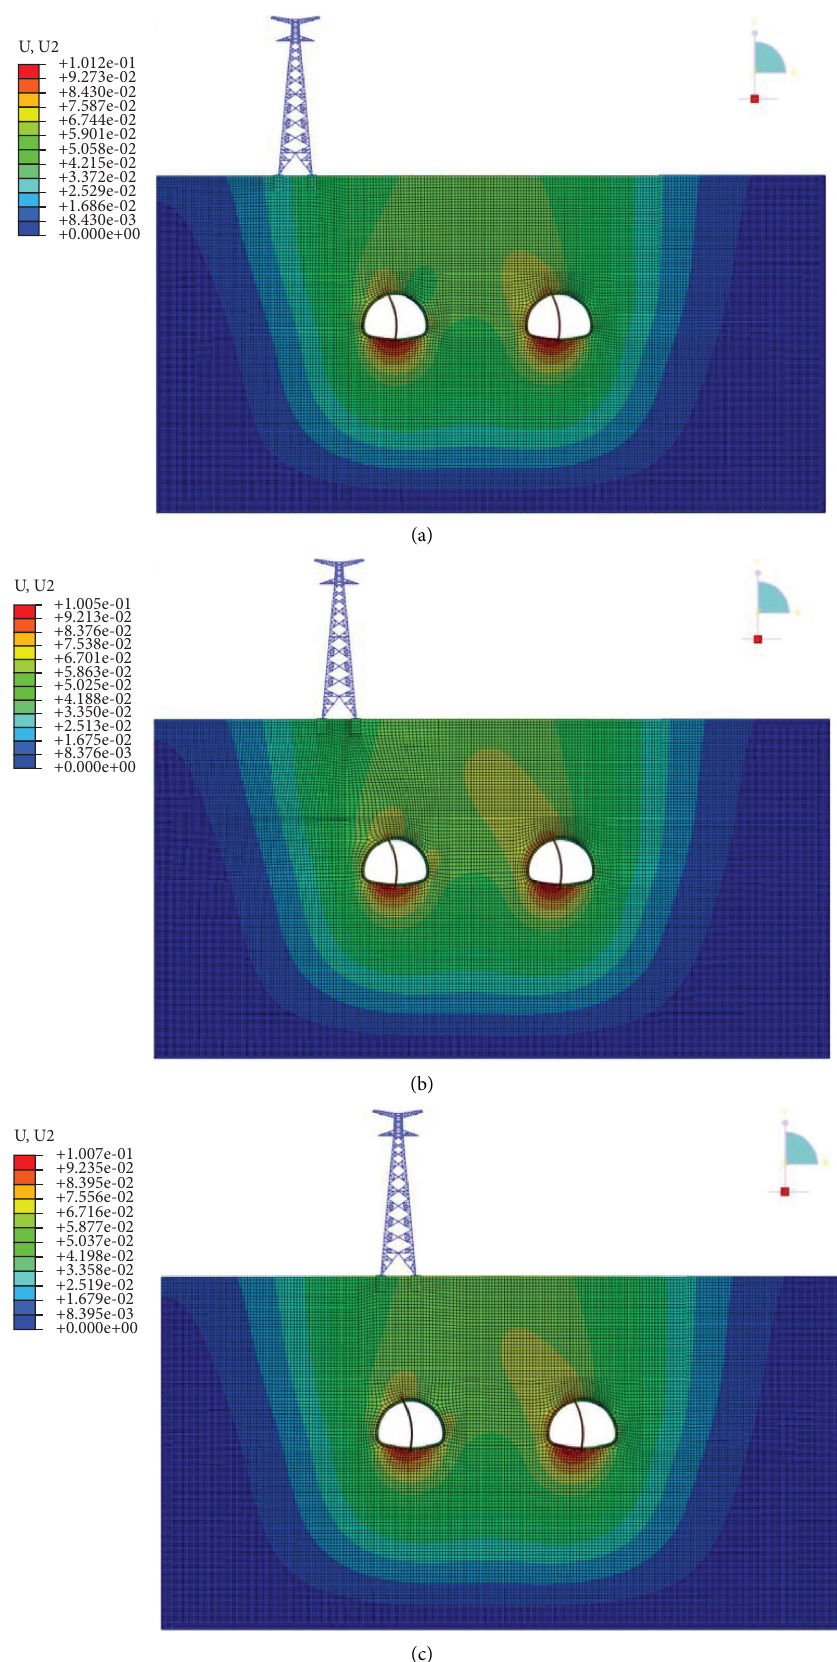
Figure 11: Vertical displacement cloud pictures under three cases with diferent horizontal distance between tunnel and tower. (a) H � 21m. (b) H � 10.5m. (c) H � 0